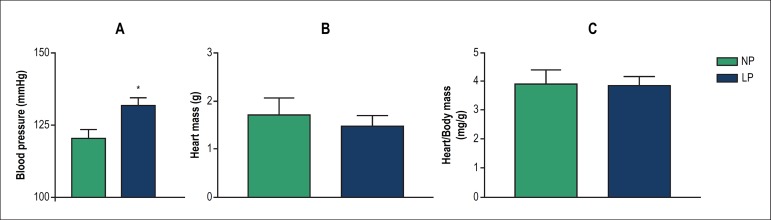
Effect of gestational protein restriction on the blood pressure
levels and their cardiac mass of the offspring at d60. (A) blood
pressure (mmHg); (B) cardiac mass (g); (C) ratio (mg/g) of the
cardiac mass and body mass in young male offspring of rats fed a
normal-protein diet (NP, full bar) or low-protein diet (LP, empty
bars) (n = 12; X ± SD, * p = 0.021 versus NP).